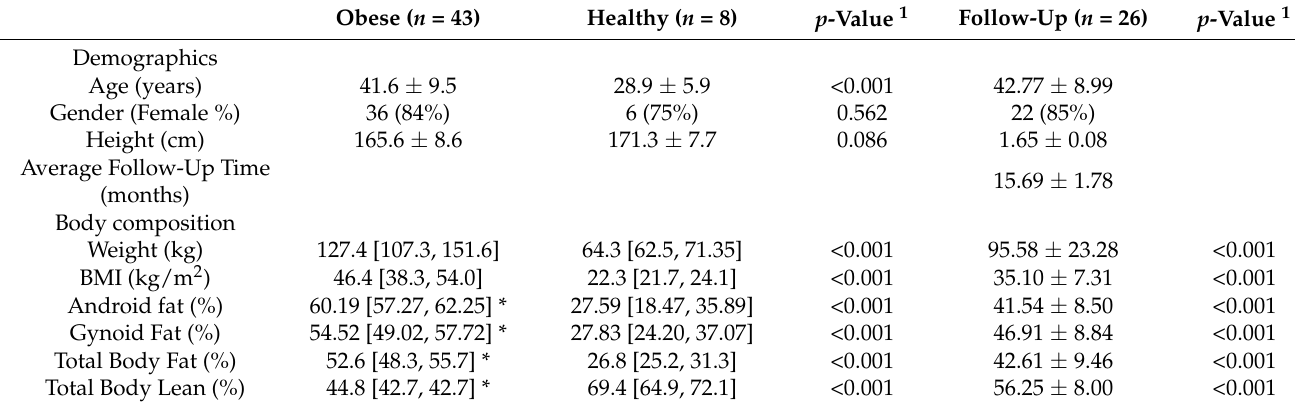
Table 1. Subject